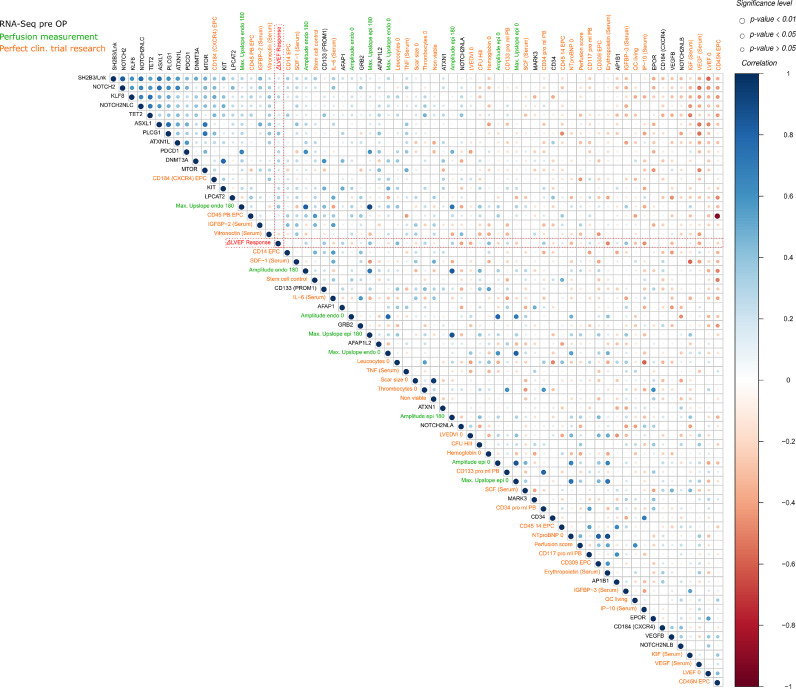
Integration of RNA-Seq, perfusion, and clinical trial research data for Pearson correlation analysis. Comparison of peripheral blood (PB) circulating cells and biomarkers (orange), MRI myocardial perfusion parameters (green), and human PB gene expression data (RNA-Seq) (black). The ΔLVEF response (red) is highlighted for an improved visual analysis of important correlations. The color scale, ranging from 1 to -1 in the upper panel (blue to red), represents the correlation between the different factors. The size of the dots represents the significance (p<0,01, p<0,05, and p>0,05; Pearson correlation) of the respective correlation (For interpretation of the references to color in this figure legend, the reader is referred to the web version of this article.).